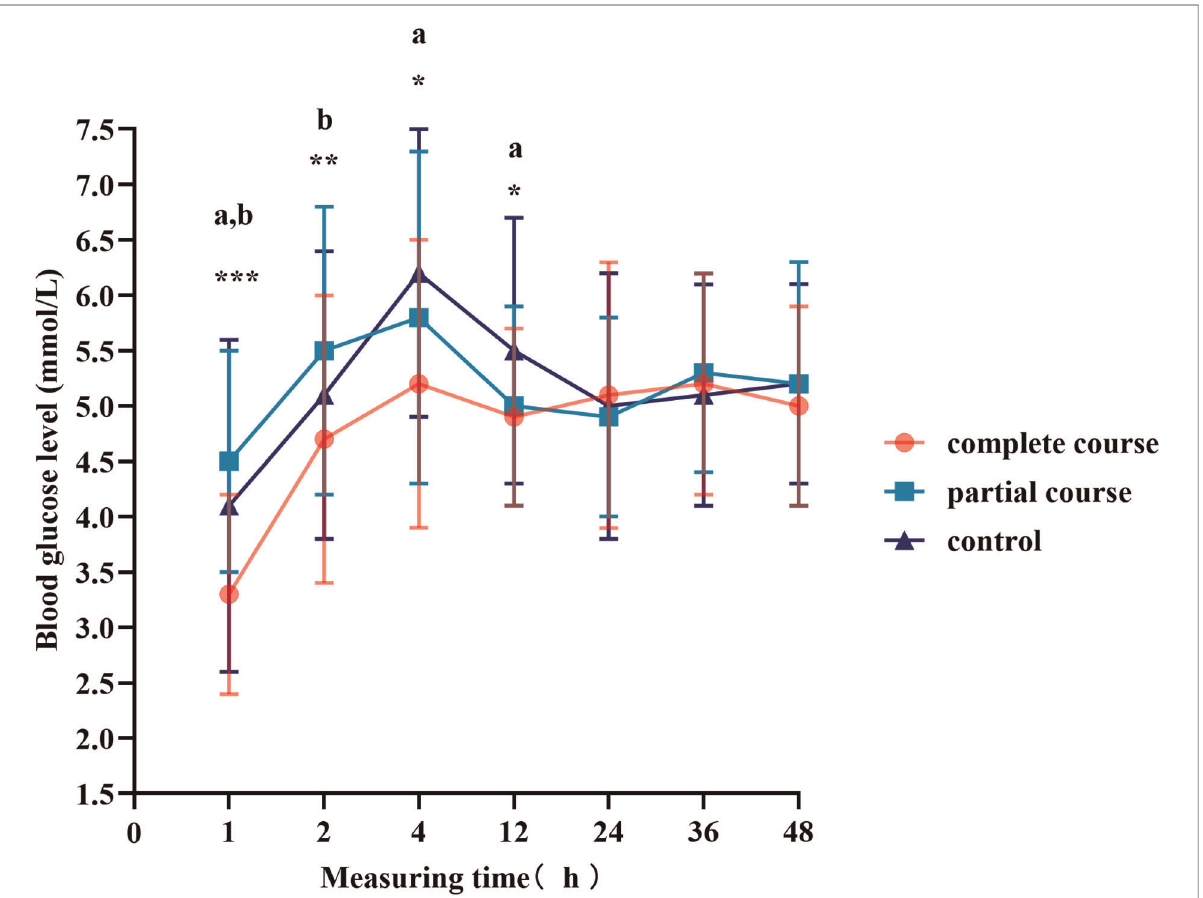
FIGURE 3 Blood glucose levels of male infants at different time points. Comparison of blood glucose levels of male infants among all groups, * p <0.05, ** p < 0.01, *** p <0.001; a p <0.0167 for the comparison of the complete or partial course group with the control group; b p <0.0167 for the comparison of the complete course group with partial